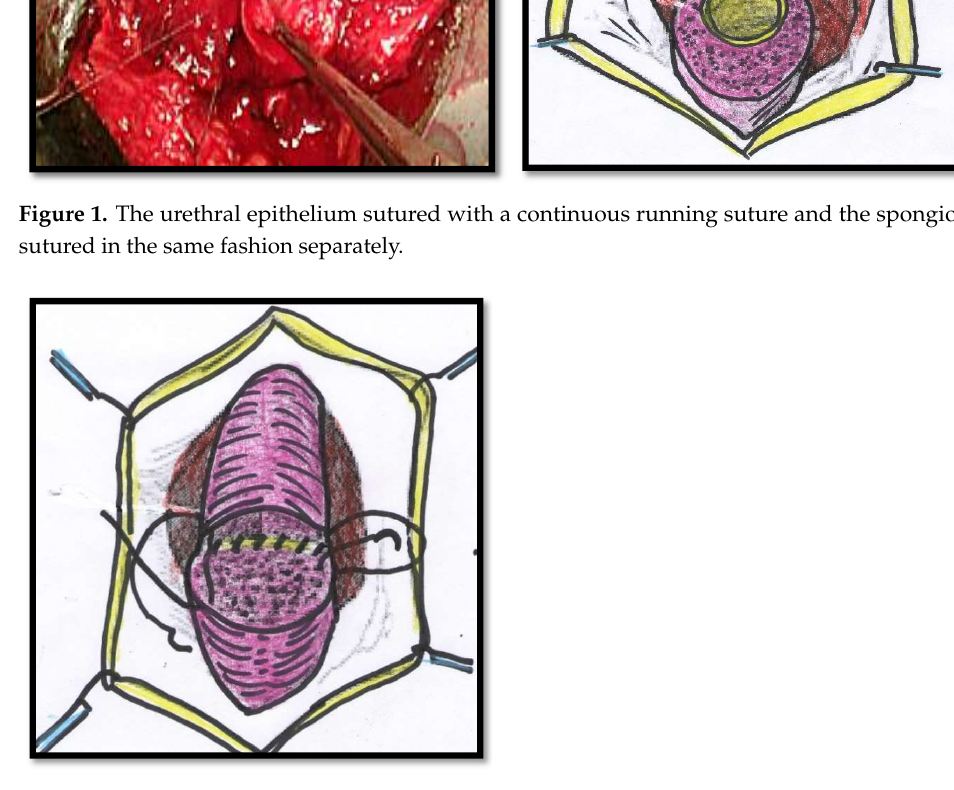
Figure 2. Closing of the spongiosum with a running suture.